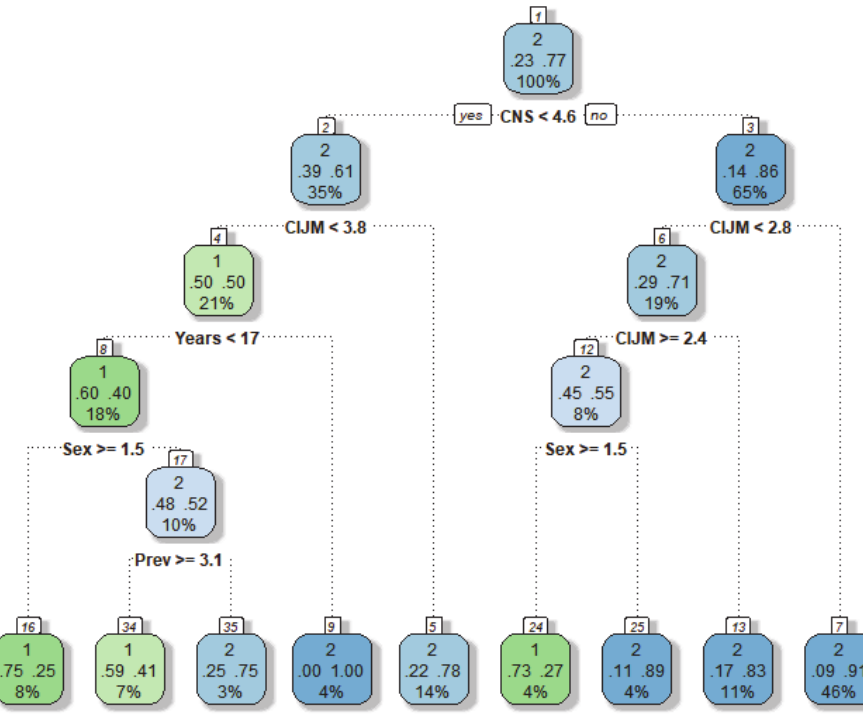
<Figure 4> Decision Tree Plot for Adopter vs. Non-Adopter